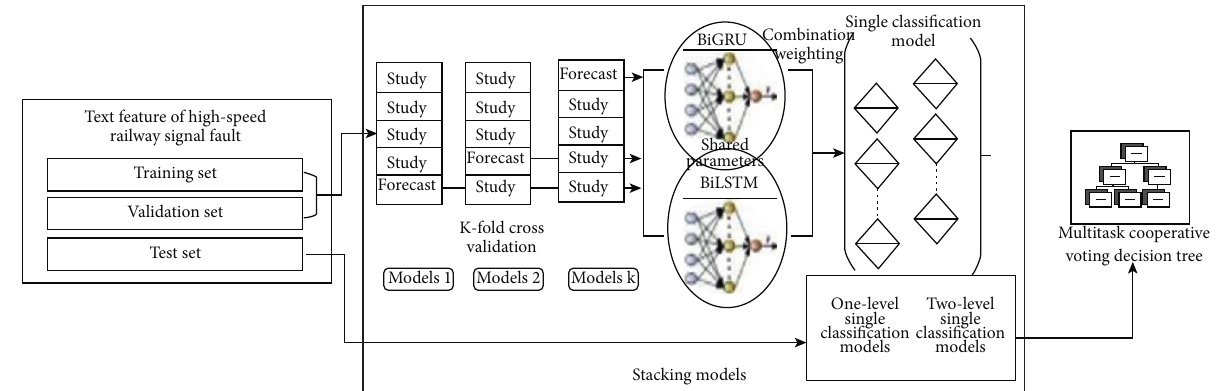
Figure 2: Fault text classification model of stacking signal equipment.